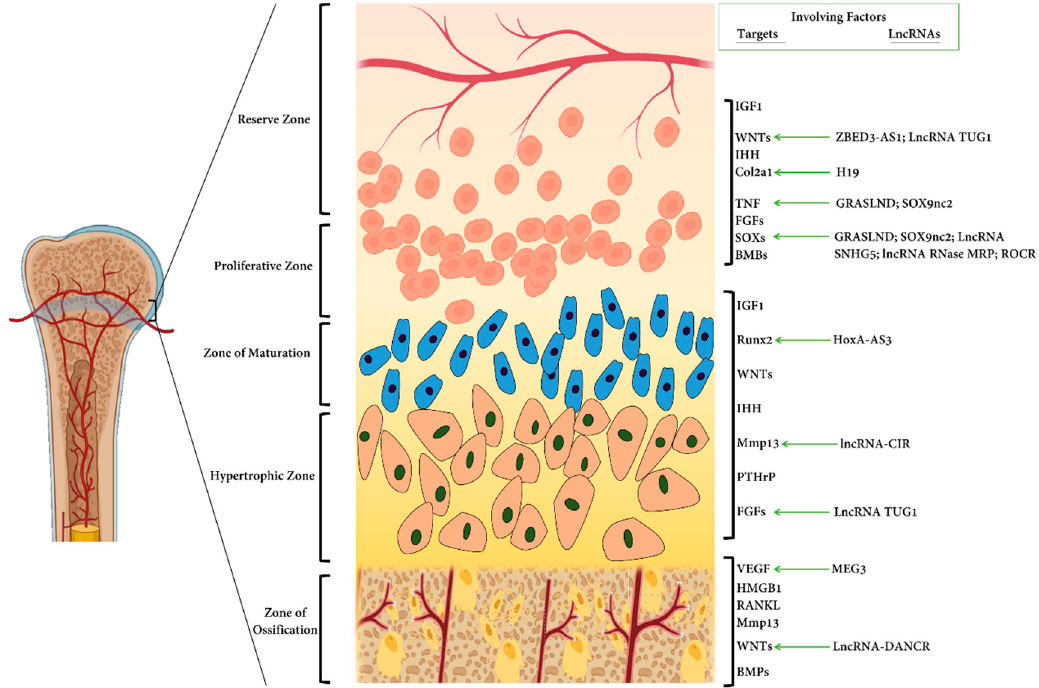
Figure 2. The growth plate can be divided into different distinct areas, each populated with cartilage cells (chondrocytes) displaying characteristic behaviors. Nearest the epiphyses is called a reserve or germinal zone involving stem cells. This region functions as a reserve of precursor cells for the proliferating chondrocytes in the columns. The second zone is a zone of proliferating chondrocytes. In this section, various genetic factors such as Indian hedgehog (Ihh) family are acting and the cells flatten and divide, laying down a cartilage ECM that will later play as a scaffold for bone formation. In the hypertrophic zone, the chondrocytes are still organized in columns, but they become ~5–12 times bigger and the amount of ECM increases, and its composition also altered. At the bottom end of the growth plate, the chondrocytes undergo apoptosis which triggers blood vessel invasion and are replaced by bone. What determines the size of these regions is still unclear. Marker/regulator gene expression in these different zones of the growth plate and the perichondrium are listed. The important long non-coding RNAs are summarized by showing their direct targets. Also, the important lncRNAs playing a major role in regulating chondrogenesis are shown. Indeed, many factors contributing to chondrogenesis are a target for their specific lncRNAs and some of the protein families, for instance Wnt family proteins, play important roles in various stages.